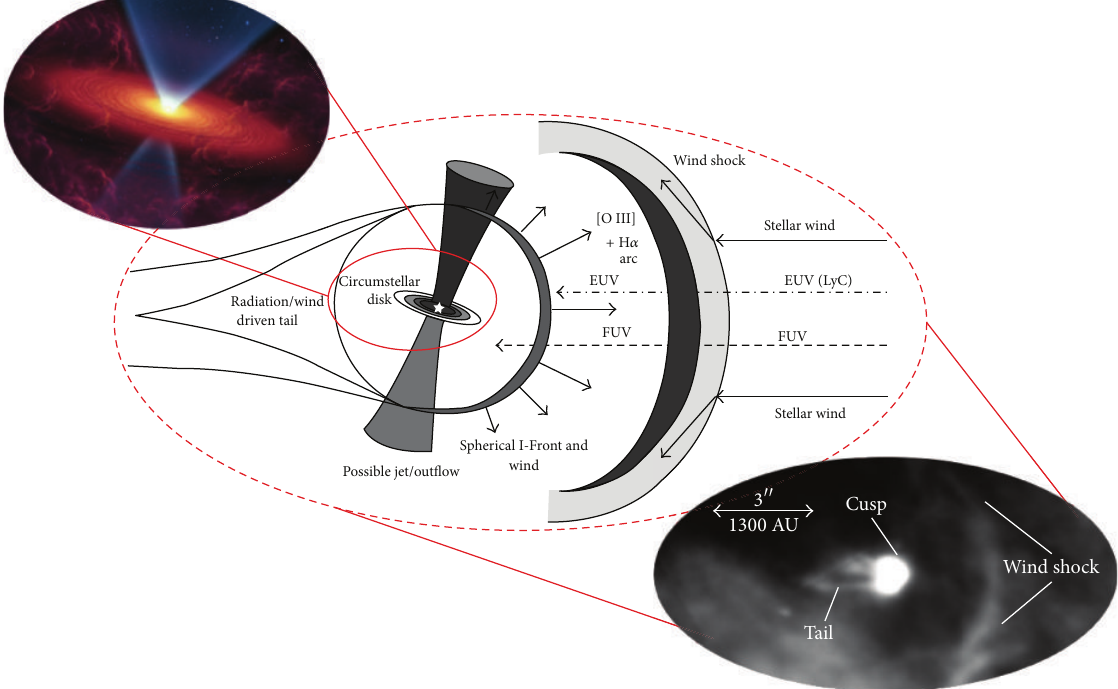
Figure 5: Schematic representation of a proplyd [61], where the young star has a circumstellar disk and a bipolar outflow. The scheme is accompanied by an artistic depiction of the circumstellar disk (upper left-hand side; Subaru Telescope Press Release on 31 August, 2005) and an H 𝛼 image of the proplyd HST1 (lower right-hand side [6]). Stellar extreme-UV (EUV) and far-UV (FUV) photons enter from the right. The FUV photons penetrate the surface of the circumstellar disk around the star, driving a slow neutral flow ( ∼ 3km s −1 ), which for most proplyds [57, 58] accelerates to mildly supersonic velocities before shocking and passing through an ionization front (I-Front) at a distance of a few disk radii. In the I-Front the gas is rapidly accelerated to about 10–20 kms −1 and continues to accelerate as it expands away from the I-Front and reaches progressively higher stages of ionization due to the EUV photons. The interaction between the photoevaporation flow and the stellar wind can produce a wind shock in front of the proplyd. The neutral flow in the tail is fed by diffuse UV photons, which evaporate the back side of the disk, and possibly also by gas that left the front side of the disk but was redirected into the tail by pressure gradients in the shocked neutral layer. The ionized flow from the tail is induced by diffuse EUV photons, but stellar EUV photons entering from the side also play an important role in maintaining the ionization of the tail flow once it has left the I-Front, especially toward the front of the tail